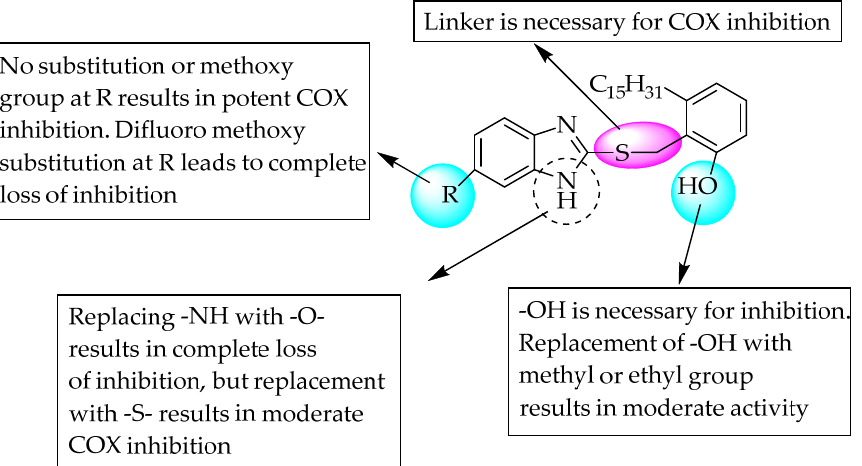
Figure 6. Structure-Activity Relationships (SARs) of anacardic acid-conjugated benzimidazole derivatives. In 2016, Bukhari et al. studied COX and 5-lipoxygenase inhibition by a few 2-phenyl- substituted benzimidazoles. As shown in Figure 7, unsubstituted at R 2 , R 3 and R 4 is preferred for COX-1 and 2, and 5-lipoxygenase inhibition, whereas the amine group at R 1 enhanced the inhibition of all three enzymes. However, the lipophilic group at R 5 favours COX-1 inhibition, a hydrophilic group enhances COX-2 inhibition and a methoxy substi- tution favours 5-lipoxygenase inhibition. One of the compounds with R 2 –CH 3 , R 1 –NH 2 and R 3 and R 4 –H showed better COX-1 inhibition, with IC 50 = 0.72 ± 0.77 µ M. However, another compound bearing a nitrile group at position R 5 was a dual (COX-1 and -2) in- hibitor with IC 50 s of 8.17 ± 2.85 and 6.79 ± 1.46 µ M, respectively. Another compound, having 2-aminopyridin-4-yl at R 5 , showed better 5-lipoxygenase inhibition, with an IC 50 of 8.41 ± 1.22 µ M. Overall, the substitution of recommended groups at the above-mentioned position favours potent COX-1 and 2, and 5-lipoxygenase inhibition [17]. The SAR of the compounds is shown in Figure